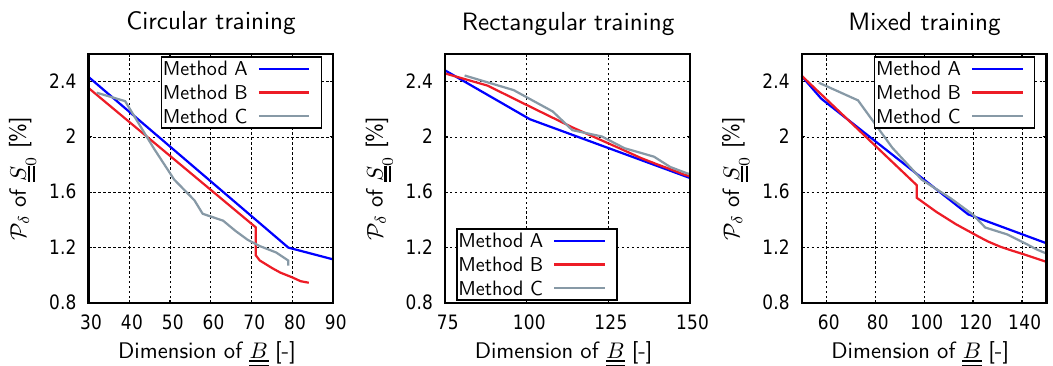
Figure 5. Development of the relative projection error basis size N over the